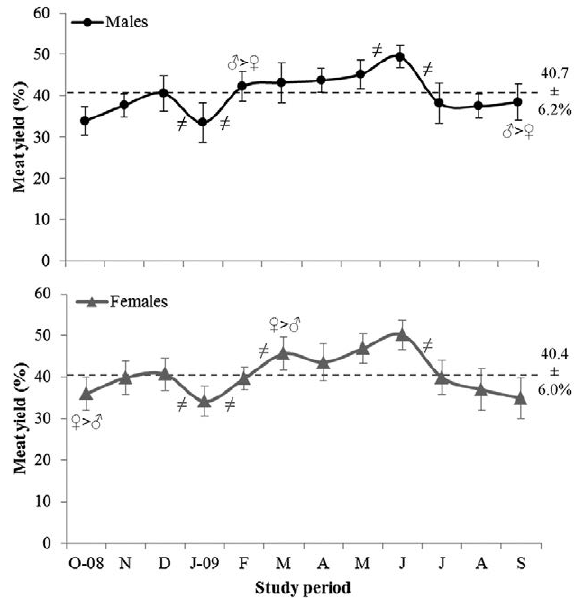
Fig. 5. – Monthly variation in the average MY of Bolinus brandaris males and females during the study period (October 2008 - Septem- ber 2009). Interrupted lines denote average MY (mean±SD). In each sex, symbols denote statistically significant differences (p<0.05) in MY between consecutive months ( ≠ ) or between sexes in each month ( ♂ > ♀ or ♀ > ♂